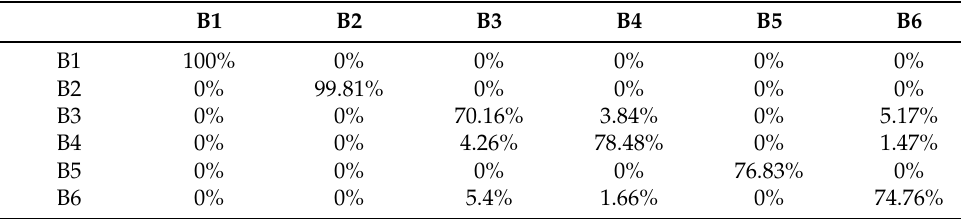
Table 3. Compatibility ratio for the Intel MAX10 x 4 + x + 1.